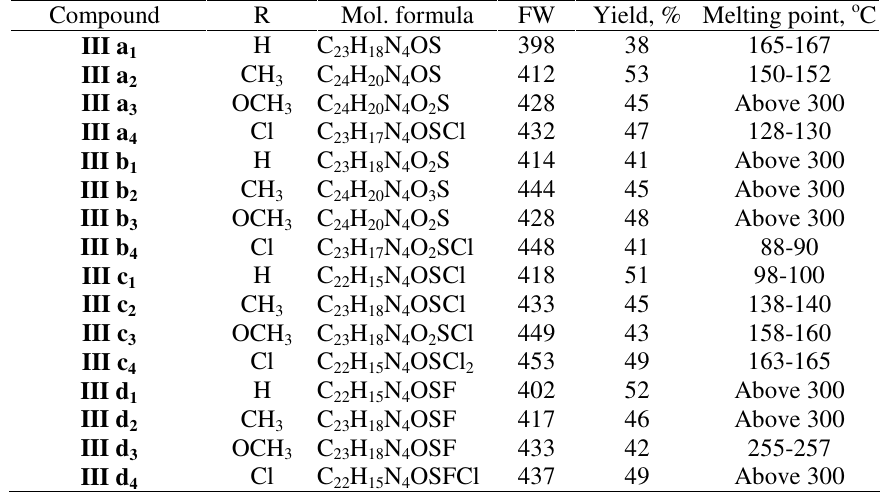
2-[(Chloroacetyl) amino] benzoic acid ( I ) IR (KBr, cm -1 ): 2923 (Aromatic CH stretching), 1650 (C=O Stretching), 1478 (C=N), 815 (1,4- disubstituted benzene), 671 (C-S). 1 H NMR (DMSO-d